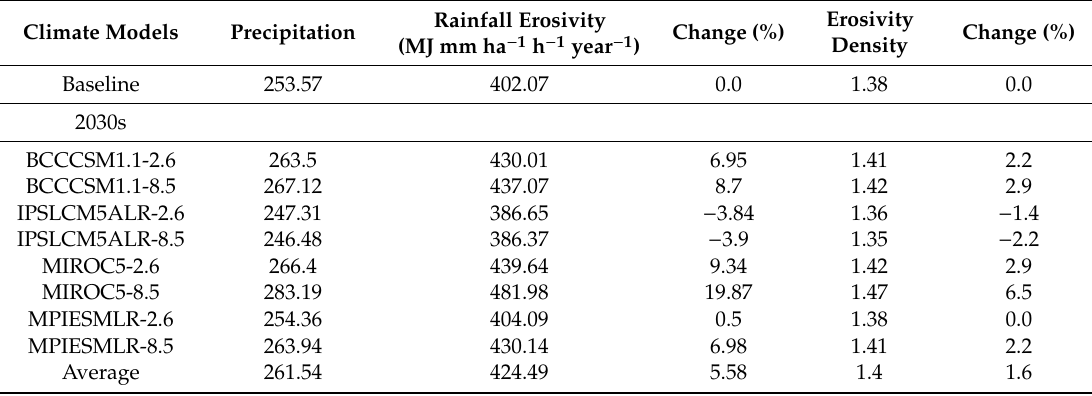
Table 2. Changes in average rainfall erosivity and erosivity density under climate change across Central Asia.